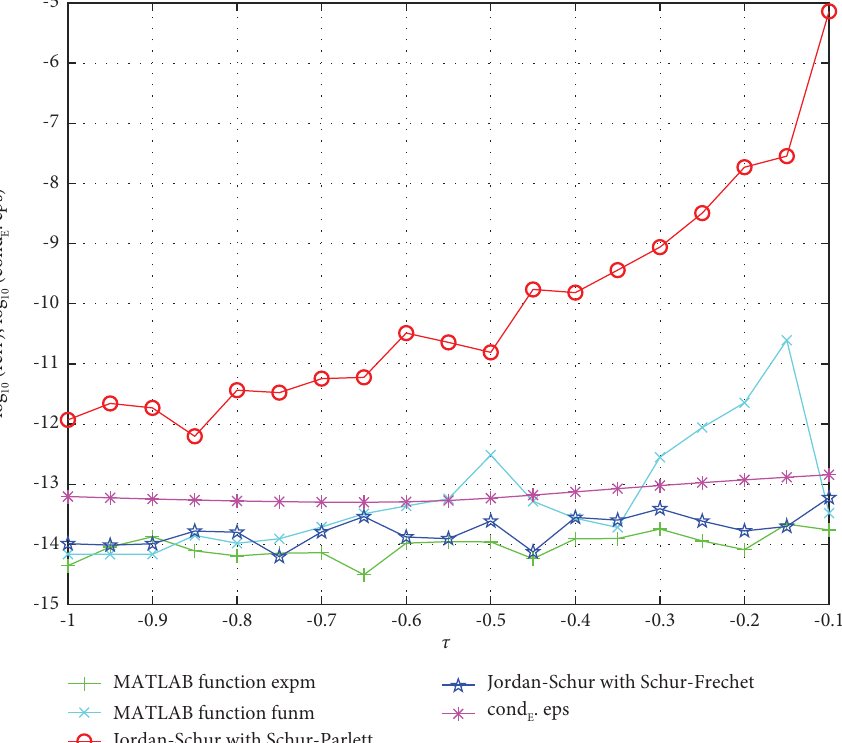
Figure 2: Relative errors for Experiment